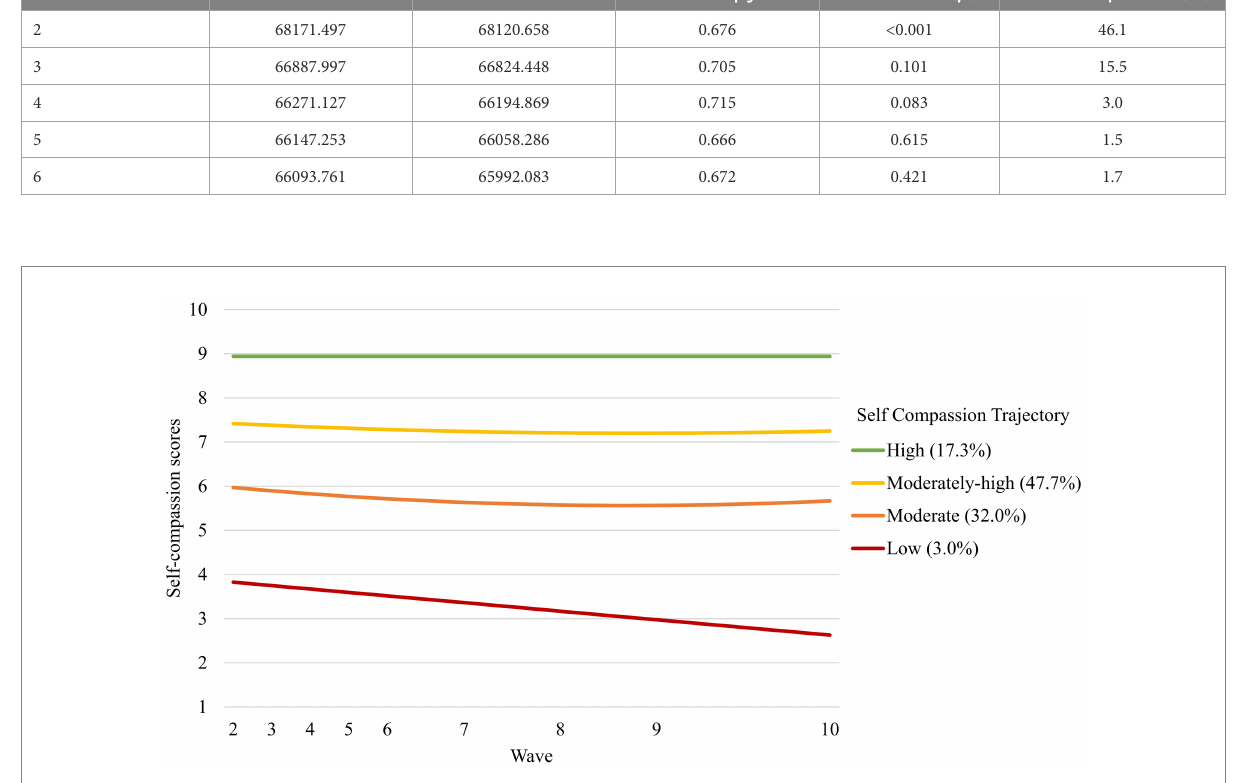
FIGURE 1 Self-compassion trajectories, 4 profile solution.